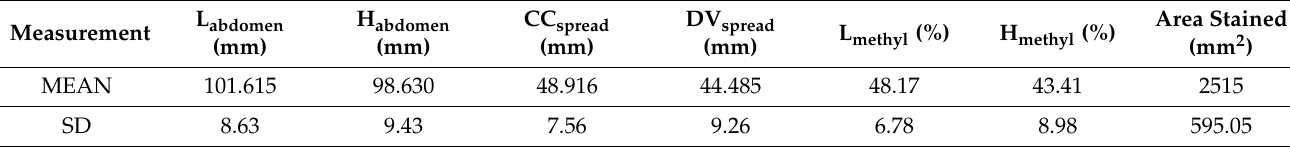
Table 1. Height and length (mean ± SD) of all hemiabdomens (H abdomen , L abdomen ) and of stained area (DV spread ; CC spread ) in millimetres (mm). The percentage of height (H methyl , %) and length (L methyl , %) of the stained area and the overall area of the spread (Area stained, mm 2 ) were also calculated and reported in the